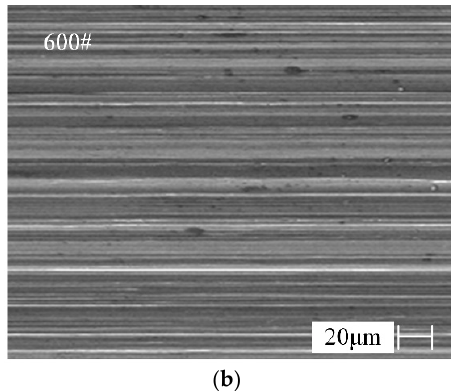
Figure 10. Surface topography by the different types of CBN wheel with normal wear. ( a ) Surface morphology by 400# CBN wheel with normal wear, ( b ) Surface morphology by 600# CBN wheel with normal wear.